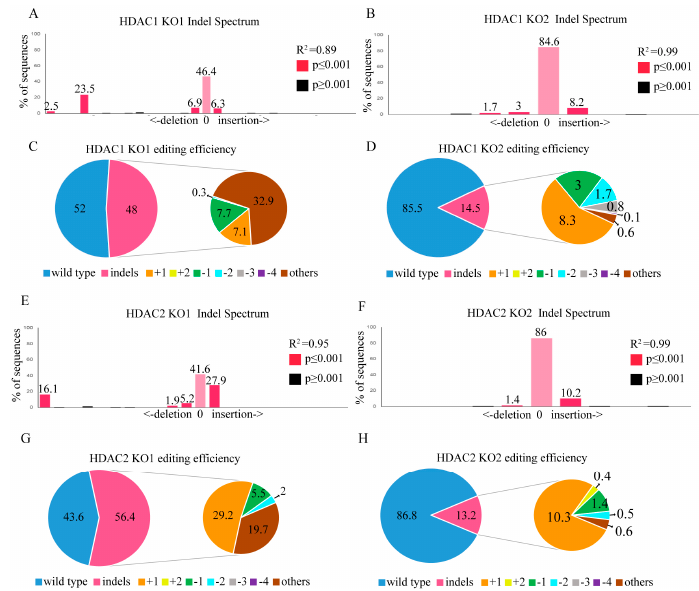
Figure 4. HDAC1 and HDAC2 gene editing of SW579 cells using the CRISPR/Cas9 system. Scrambled (SC) sgRNA and HDAC1 sgRNA were delivered to SW579 cells by lentivirus. After transduction, DNA from virus-infected cells was purified and subjected to Sanger sequencing of HDAC1 exon 2. The TIDE algorithm analysis is shown for ( A ) HDAC1 KO1 and ( B ) HDAC1 KO2 virus-transfected gene edited by HDAC1 ( C ) KO1 and ( D ) KO2 lentivirus. The gene editing efficiency of the two KO